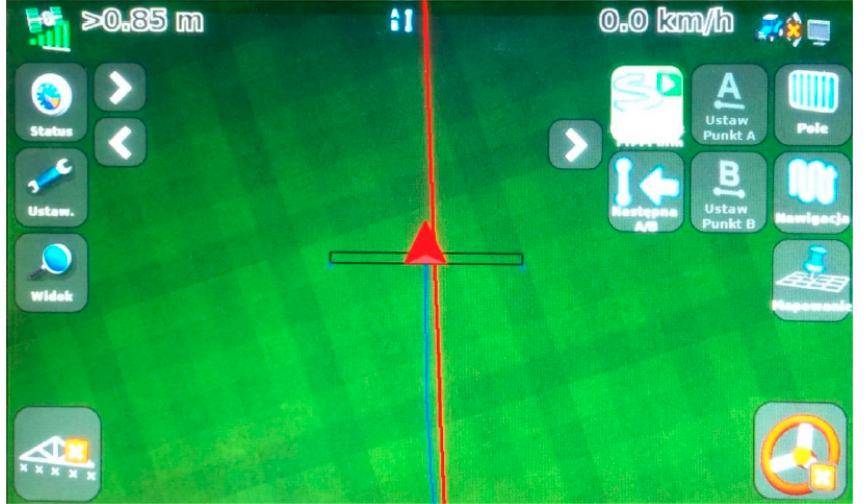
Figure 2. Image seen by the operator on the screen of the Trimble CFX 750 navigation panel—sample recording of the preset (red line) and actual (blue line) vehicle track.